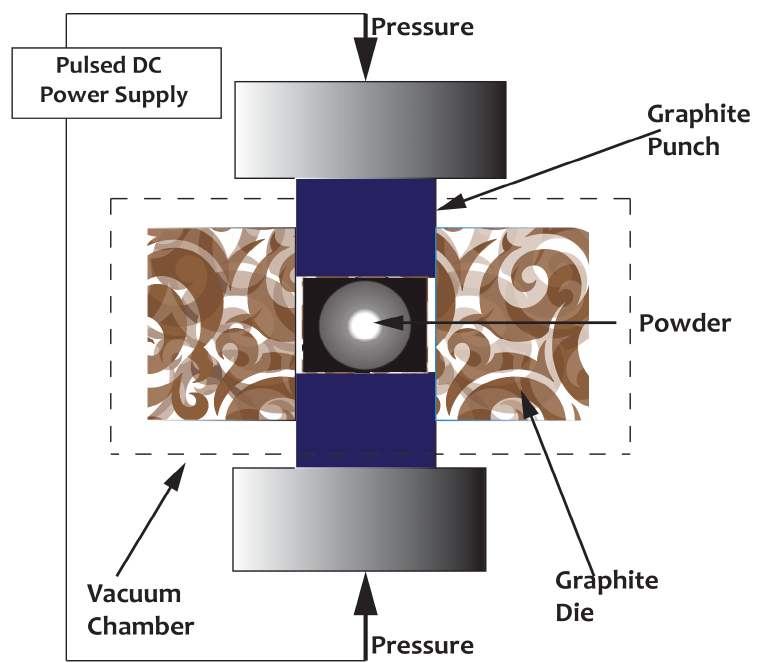
Figure 1. Spark plasma sintering diagram in 2D.